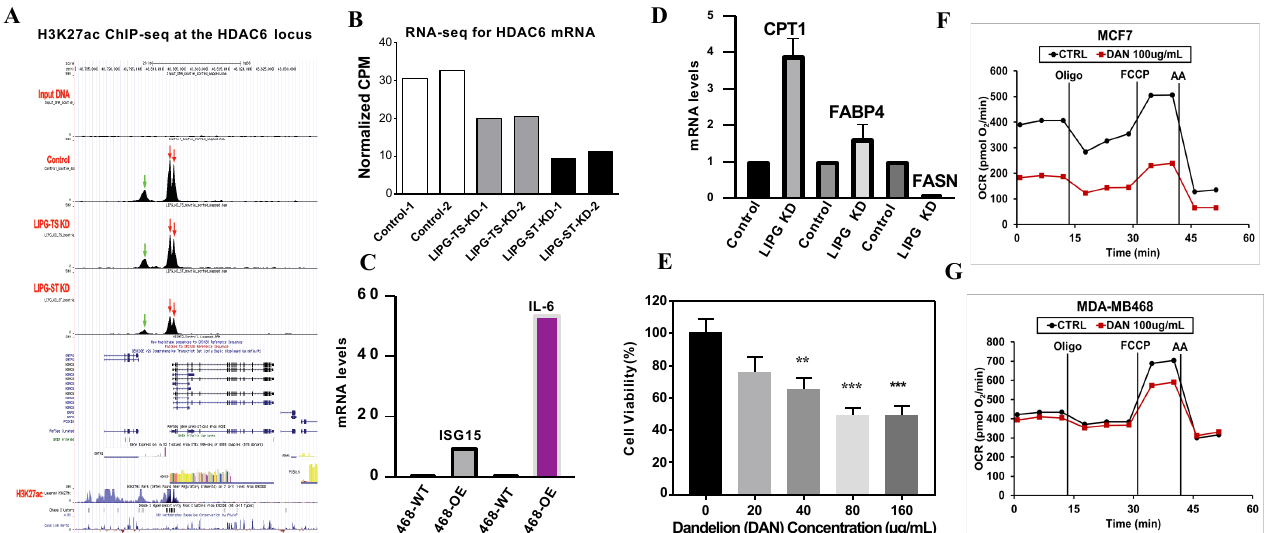
Figure 3. LIPG alters histone acetylation and HDAC6 expression. ( A ) Gene track view for H3K27ac ChIP-seq data at the HDAC6 locus in the indicated cell lines. Two major peaks are located at the promoter region of the HDAC6 gene (indicated by red arrows), and the third peak is located at the distal upstream region (indicated by a green arrow). ( B ) RNA-seq analyses of HDAC6 mRNA levels in the indicated cell lines. ( C , D ) qRT-PCR analyses of mRNA levels of ISG15, IL-6, CPT1, FABP4, and FASN in MDA-MB-468 cells. OE: LIPG-overexpressing MDA-MB-468 cells. KD: LIPG knockdown MDA-MB-468 cells. Control: MDA-MB-468 cells. ( E ) MDA-MB-231 cells were treated with dandelion extract for 24 h, and MTT assays were performed for cell viability. ** p < 0.01; *** p < 0.001. ( F , G ) Seahorse analyses of OCR in the indicated cell lines treated with dandelion (DAN) extract for 24